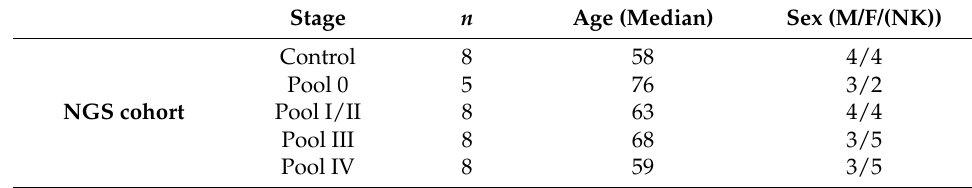
Figure 1. RNAseq results from circulating transcriptome. ( a ) Typical length–frequency of obtained reads in library. Proportion of reads mapping to different categories of sRNA for ( b ) control pool, ( c ) stage 0 pool, ( d ) stage I/II pool, ( e ) stage III pool, ( f ) stage IV pool. Table 1. Summary of clinical details of patient cohorts used in study. NK: not known.